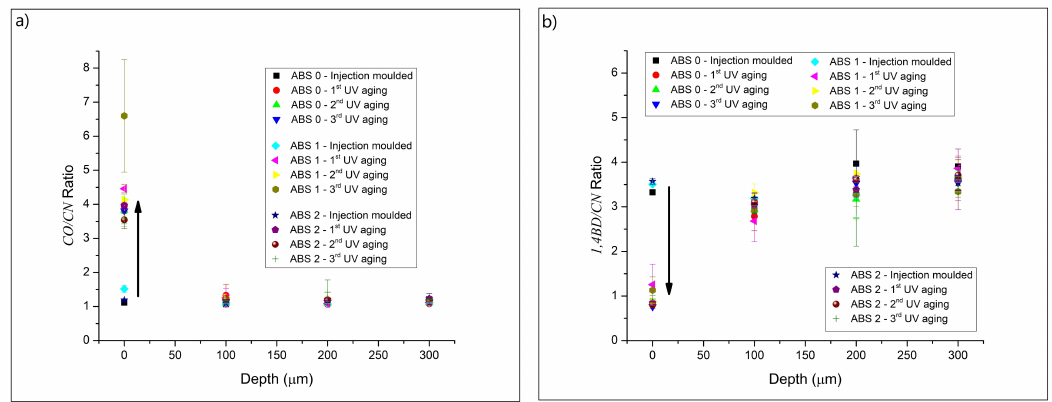
Figure 3. Absorption ratios for the side exposed to UV at different depths (Depth 0 = surface of the samples) for samples in Table 1 (all three entries) and up to two extra cycles; ( a ) CO/CN ratio, and ( b ) 1,4BD/CN ratio (Equations (1) and (2)). Substantial degradation is observed only at the